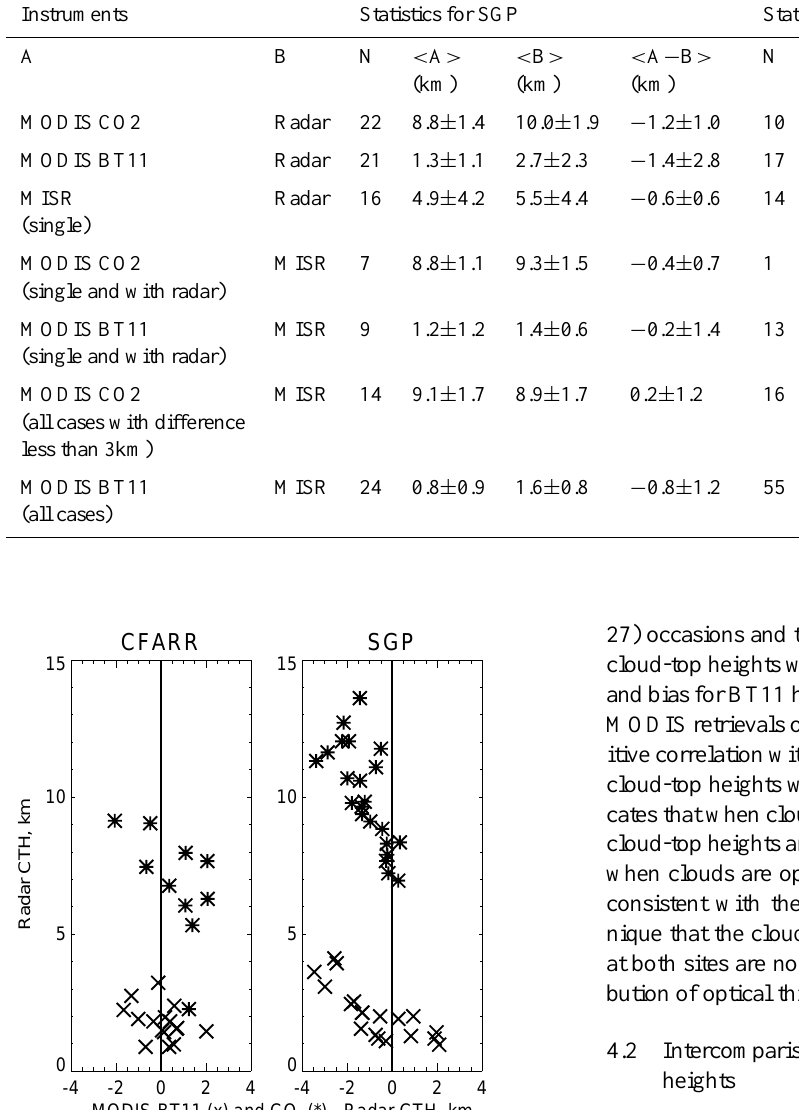
Table 1. Summary of all differences in cloud-top heights (CTH) for both sites and all instruments. N represents the number of cases, < A > and < B > the average CTHs for each instrument and < A − B > the average difference in CTH between instruments A and B.